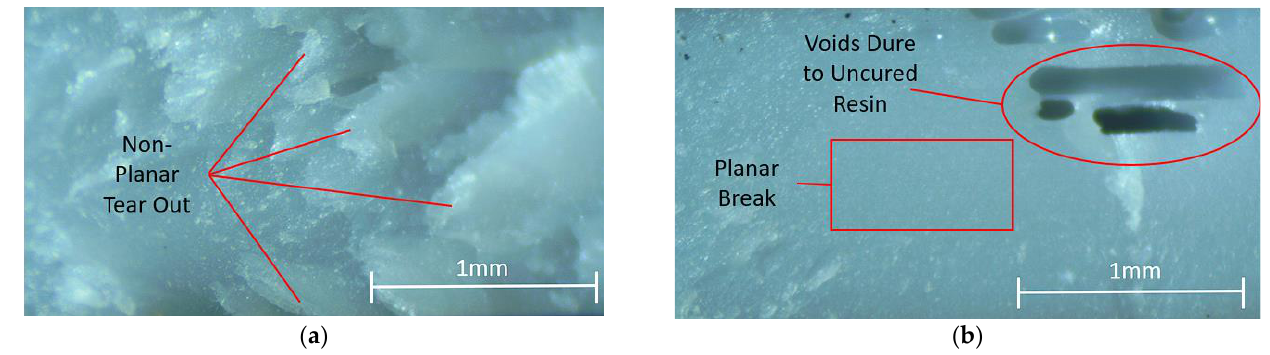
Figure 6. ( a ) Optical microscope image of fracture point of 7.5% sample ( b ) Optical microscope im- age of fracture due to voids on 7.5%